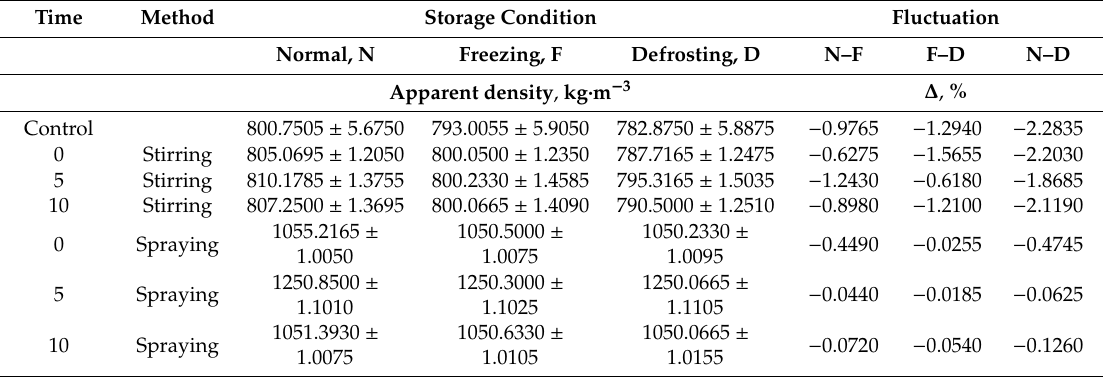
Table 3. Descriptive analysis for the apparent density of non-wood pellets with addition by stirring or spraying of liquid-state food waste subjected to the process of freezing–defrosting.